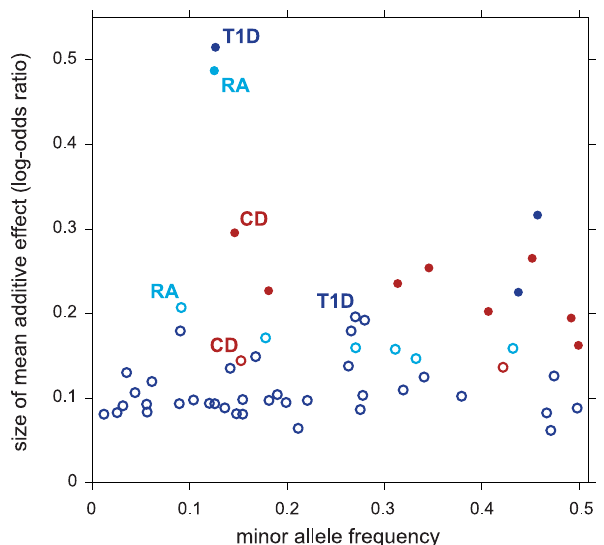
Figure 4. Variants in non-MHC disease regions revealed by enriched pathways have smaller effects on disease risk. Each point in scatterplot corresponds to a 50-SNP segment outside the MHC for which P 1 § 0 : 5 . Filled circles correspond to selected regions containing disease risk factors without feedback from enriched pathways ( P 1 § 0 : 5 D h ~ 0 ); open circles correspond to selected regions conditioned on enrichment ( P 1 § 0 : 5 D h w 0 and P 1 v 0 : 5 D h ~ 0 ). For each segment, minor allele frequency and posterior mean additive effect of minor allele count on log-odds of disease (‘‘log-odds ratio’’) are taken from SNP in segment with highest probability of being included in multi-marker model.